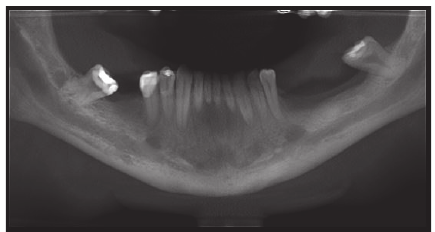
Figure 1: Panoramic Radiograph of the case. Enlargement of mandibular canal in both sides.